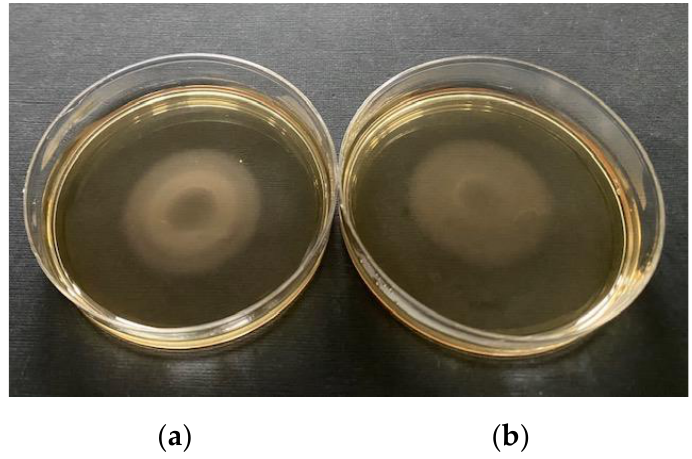
Figure 6. Campylobacter motility. Motility of C. jejuni strain did not change ( a ) before and ( b ) after centrifugation.